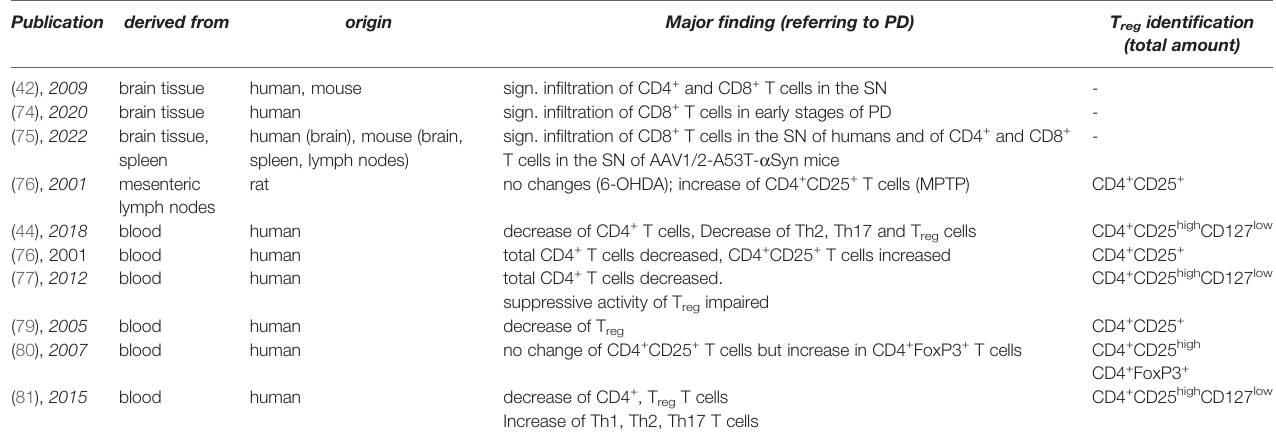
TABLE 1 | Overview of human and animal studies on T cells with special regard to T reg cells. Publication derived from